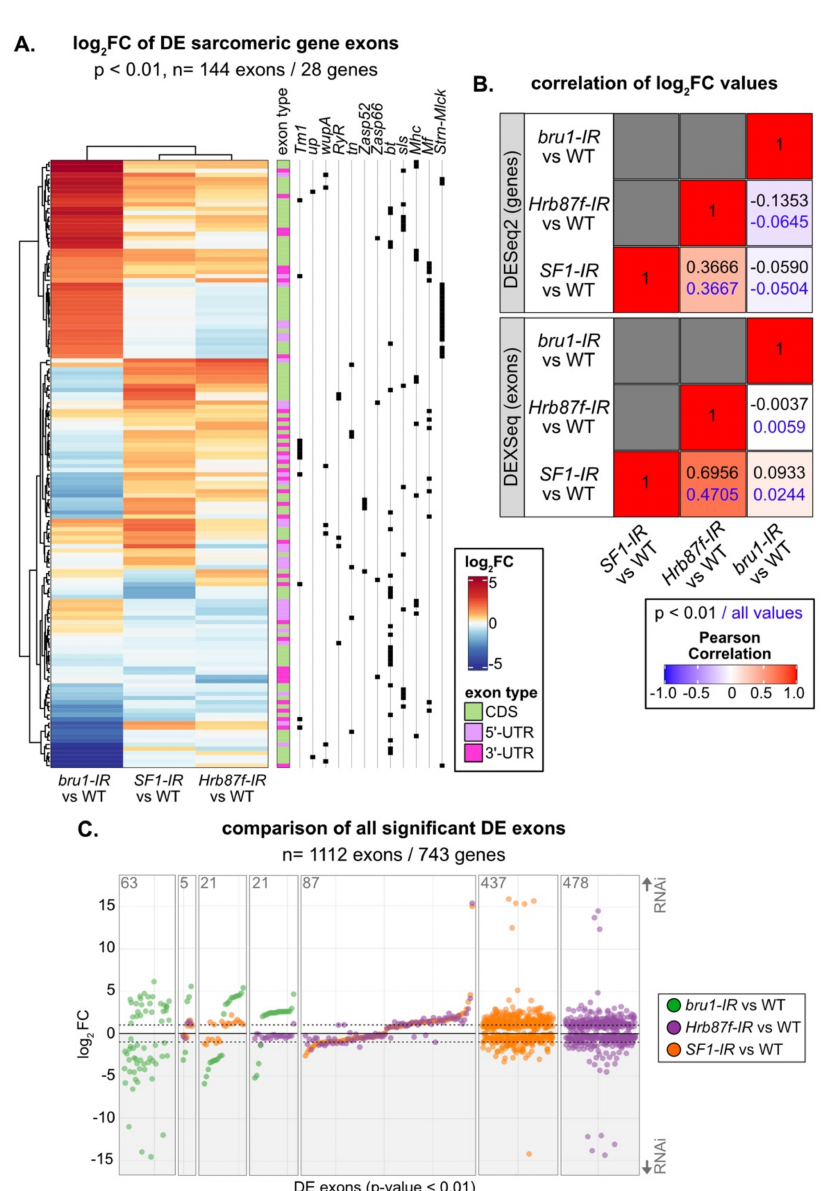
Figure 8. Changes in exon use profiles in SF1-IR and Hrb87F-IR are distinct from those in bru1-IR . ( A ) Heatmap and hierarchical clustering of log 2 FC expression values for all 144 sarcomeric gene exons significantly differentially expressed (DEXSeq p value < 0.01) in either bru1-IR , SF1-IR or Hrb87F-IR . Note the similarity in expression between SF1-IR and Hrb87F-IR and difference to bru1-IR , although all three knockdowns affect myofibril and sarcomere development. Exons are classified as coding (CDS, green), 5’-UTR (pink) or 3’-UTR (magenta) based on Flybase annotation. Black squares denote individual exons from the same gene. For multiple sarcomere genes, different sets of exons are up- and downregulated indicating alternative isoform use. ( B ) Plot of Pearson’s correlation coefficients of log 2 FC values from gene expression and exon use analyses between bru1-IR , SF1-IR and Hrb87F-IR . Coefficient values for comparison of all significant genes (DESeq2 adjusted p value < 0.01) and exons (DEXSeq p value < 0.01) are shown in black, and for comparison of all genes or exons irrespective of significance is shown in blue. ( C ) Plot of log 2 FC values for all 1112 significantly DE exons (DEXSeq p value < 0.01) genome wide ( bru-IR exons, green; Hrb87F-IR exons, purple; SF1-IR exons, orange). The number of exons is noted in the top left of each plot region. Gray shaded regions contain exons that are downregulated in the knockdown condition. Note the different regulatory dynamics for individual exons between bru1-IR and SF1-IR or Hrb87F-IR , the similar dynamics in regulation between SF1-IR or Hrb87F-IR and the large number of exons regulated in only one